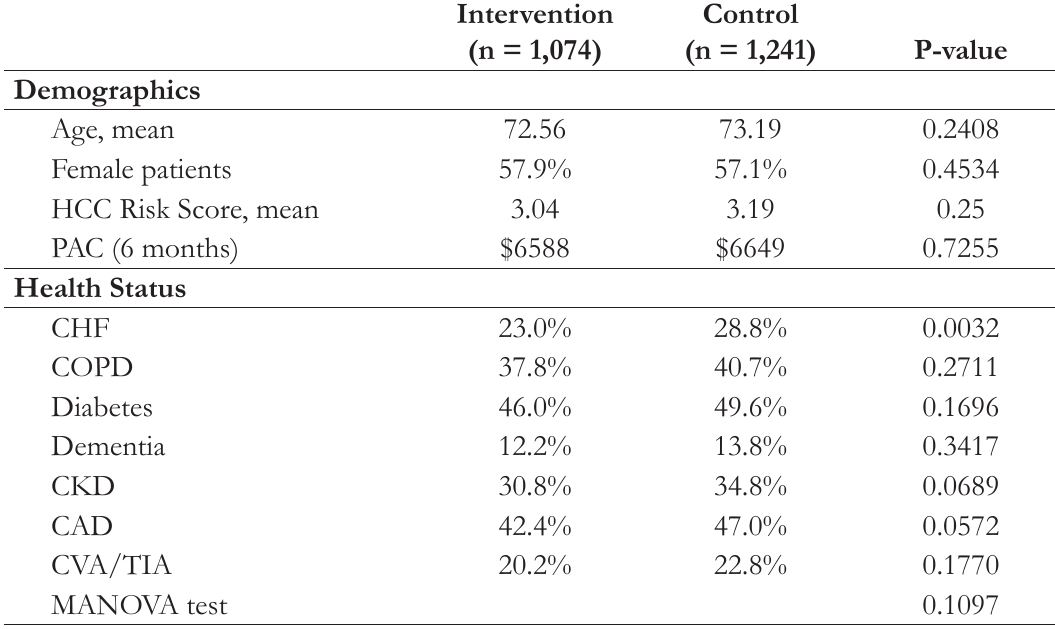
Table 1. Baseline Characteristics of Intervention and Reference Population used as Control